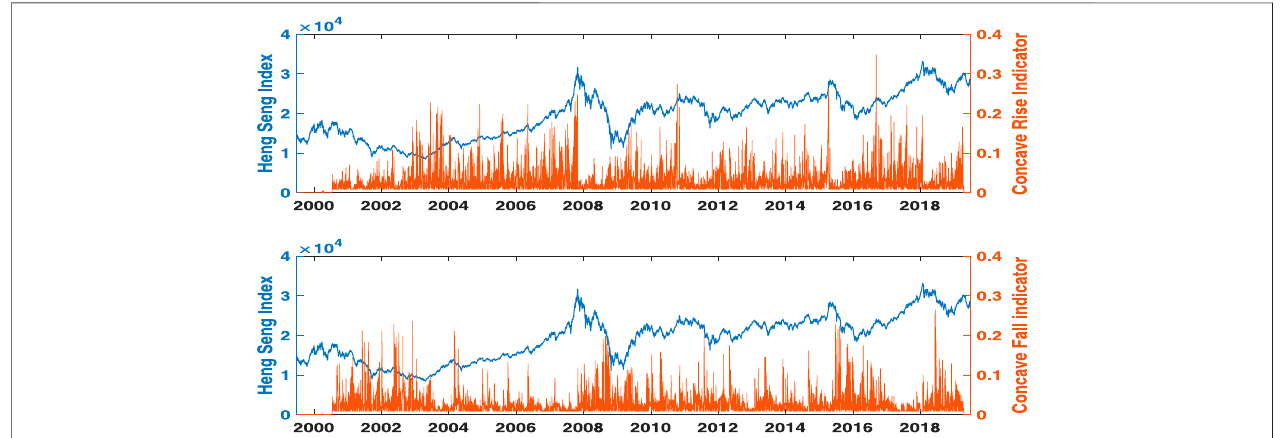
FIGURE4| Pricemotionindicators measure ARand DFin theHang SengIndex from June 28,1999, toJune28, 2019. Concave rise and fallindicatorsare shown in the upper and lower panels, respectively.The HangSeng Index is plotted using blue lines, while the indicators use red bars. The time scope is set toS (cid:2) 262, which is equal to the number of trading days per